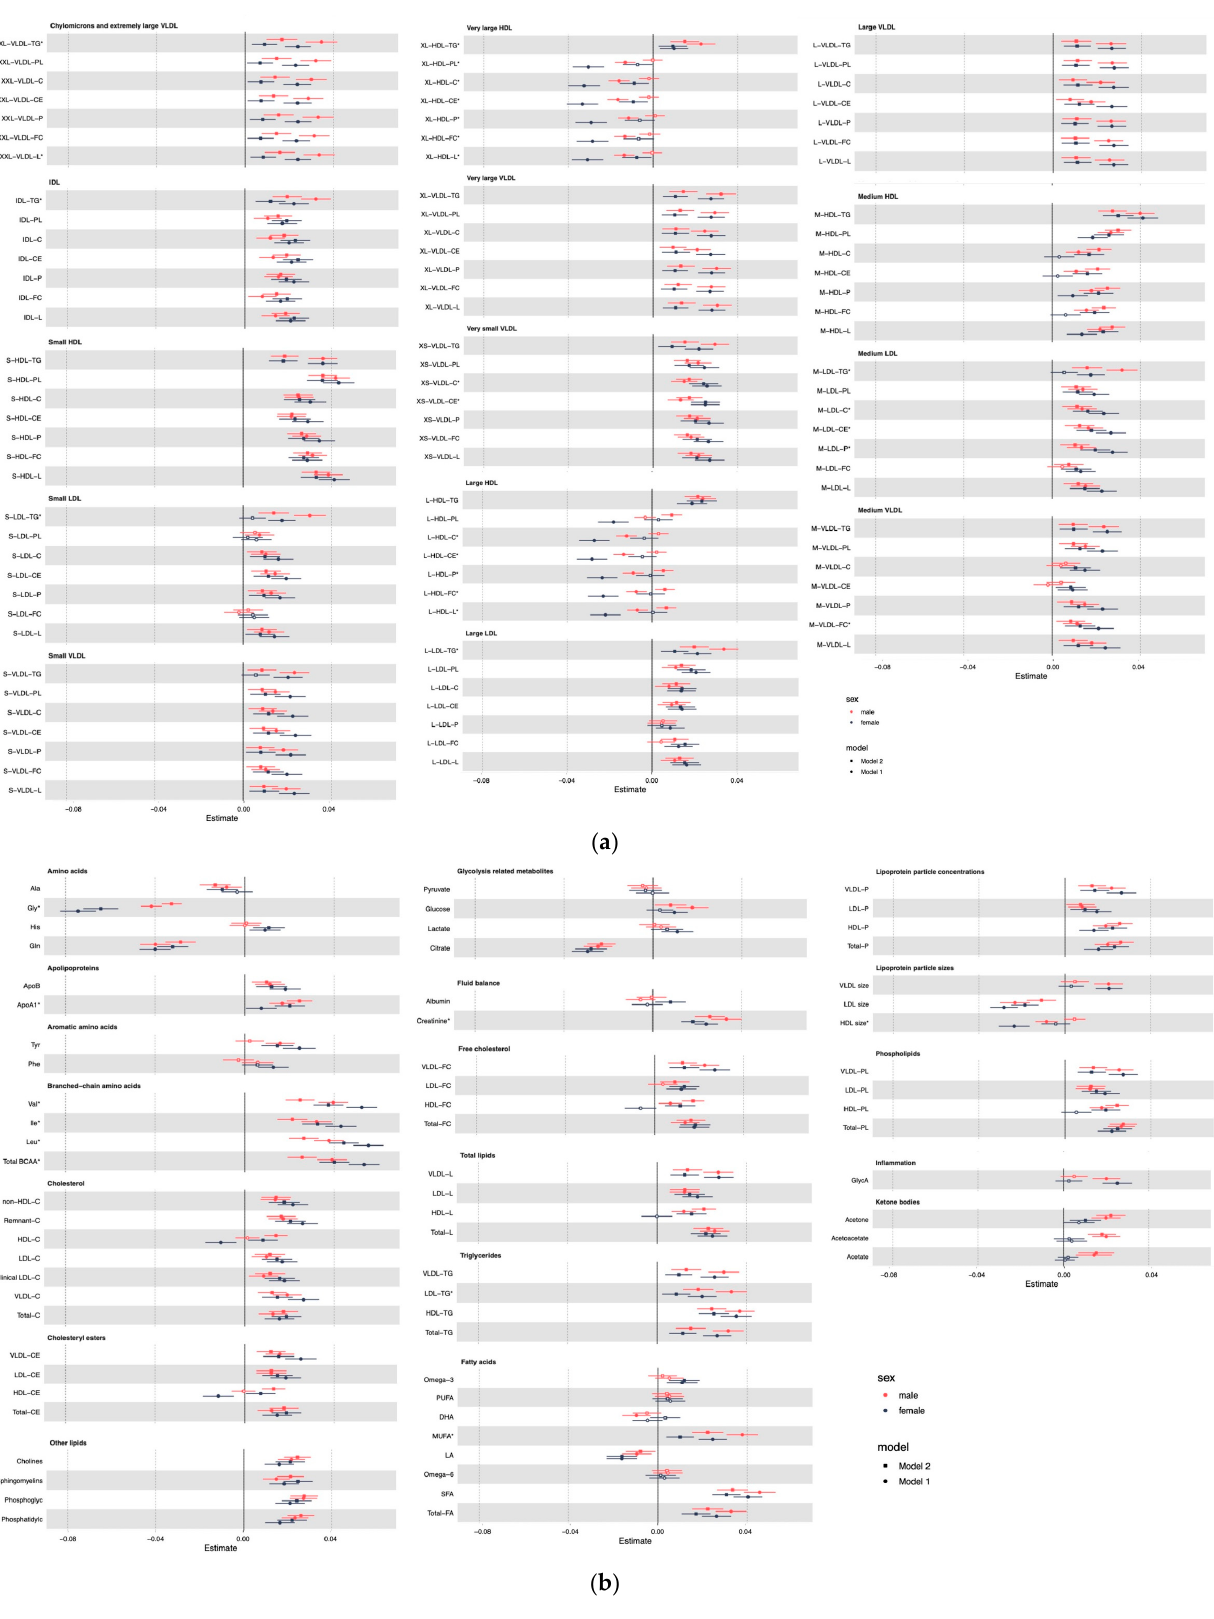
Figure 1. Associations of unprocessed red meat consumption with metabolites in men and